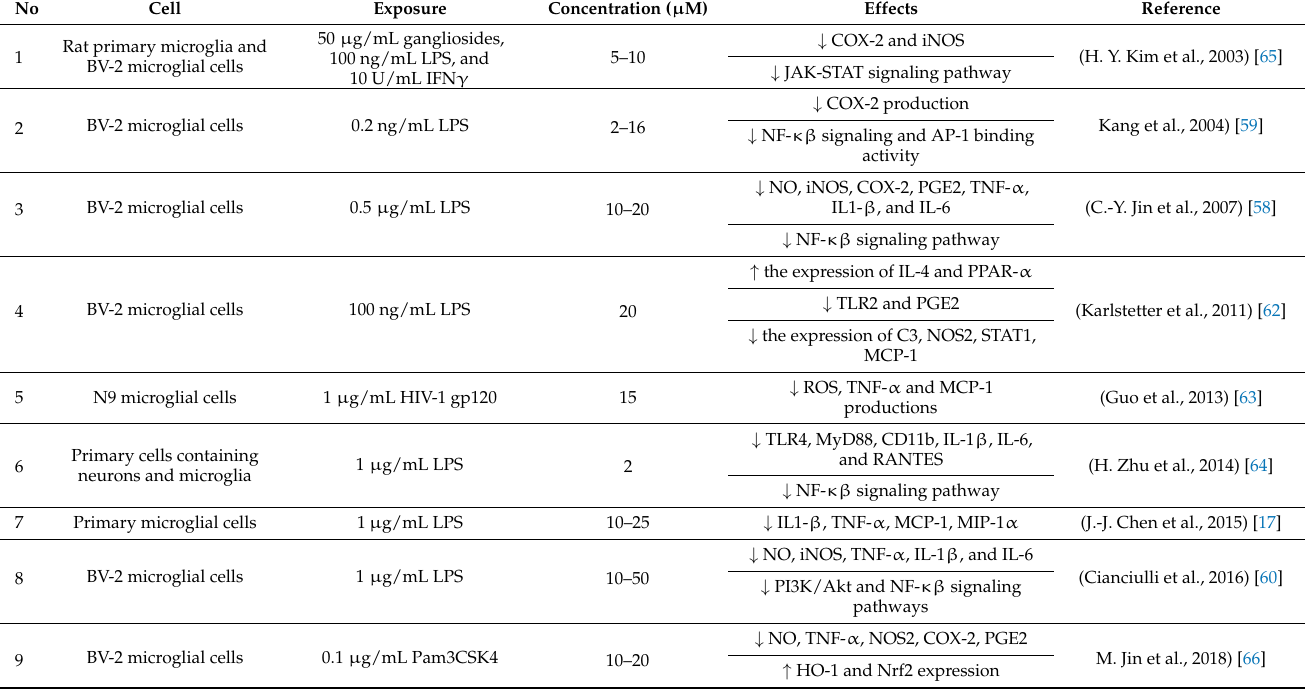
Table 1. Overview of the effect of curcumin on the activated microglia assayed in cultured